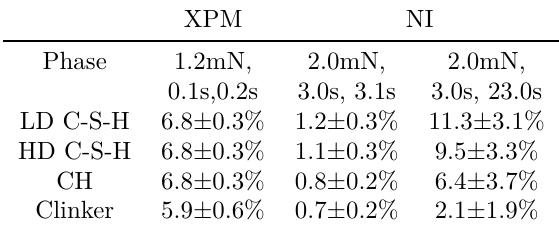
Table 1. Creep indentation parameter CIT calcu- lated in different phases for XPM and